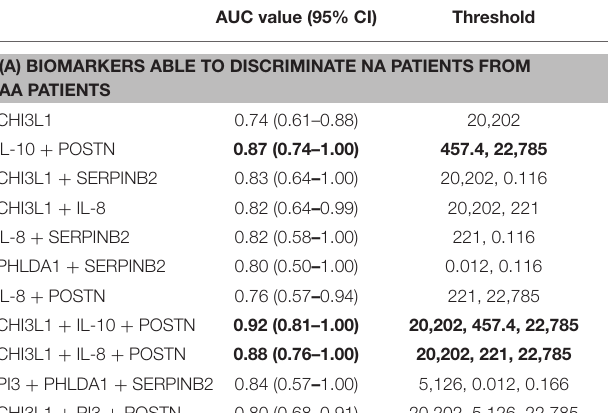
TABLE 5 | Ranking of the best individual and combined proteic biomarkers for each